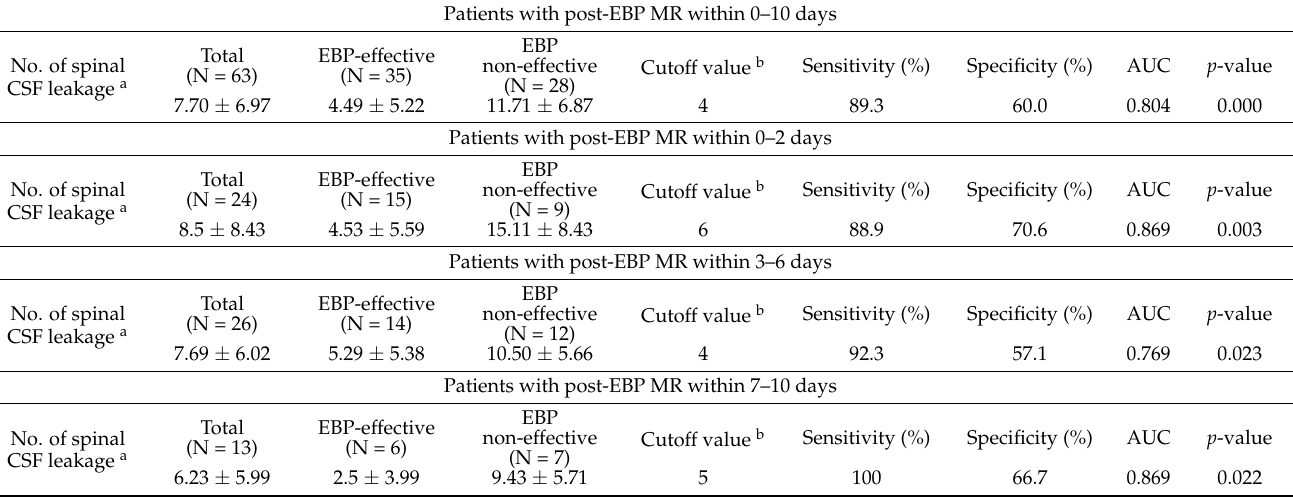
Figure 1. Distribution of the no. of spinal CSF leakage noted in post-EBP MRI in EBP-effective ( • ) and EBP non-effective groups ( (cid:78) ). Most EBP non-effective patients had a higher no. of spinal CSF leakage than EBP effective patients. Furthermore, for EBP-effective patients, their no. of spinal CSF leakages seemed stepwise decreased with increased follow-up days. Table 2. The no. of spinal CSF leakage between EBP effective and non-effective groups and the cutoff values for prediction of EBP failure in different post-EBP MR time